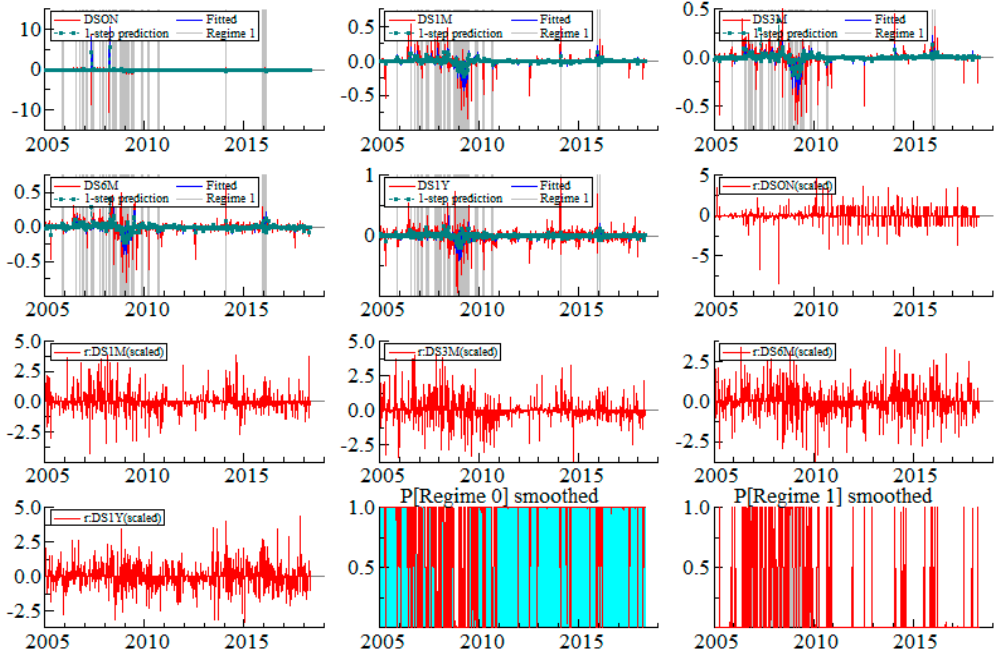
Figure A9. South Africa Regime-switching modeling: Msiah (2)-Vecm (1). Note: Regime 1 denotes the high-volatility regime, whilst Regime 0 the low-volatility one [8,25].